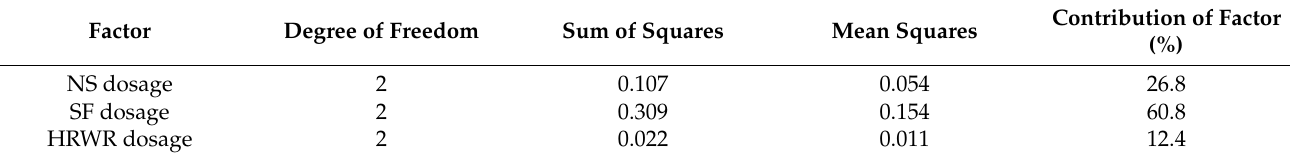
Table 11. Analyses of variance (ANOVA) for absorption coefficient by capillarity.